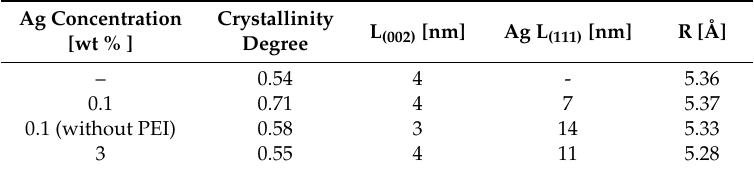
Table 1. Degree of crystallinity of cellulose fibers.